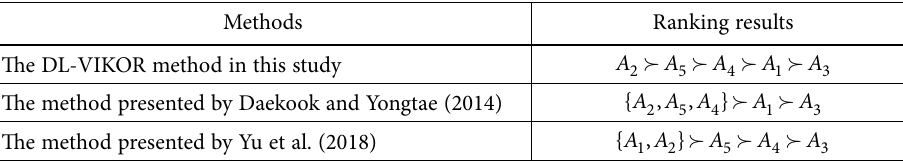
Table 6. Comparison of ranking results by using three methods Methods Ranking